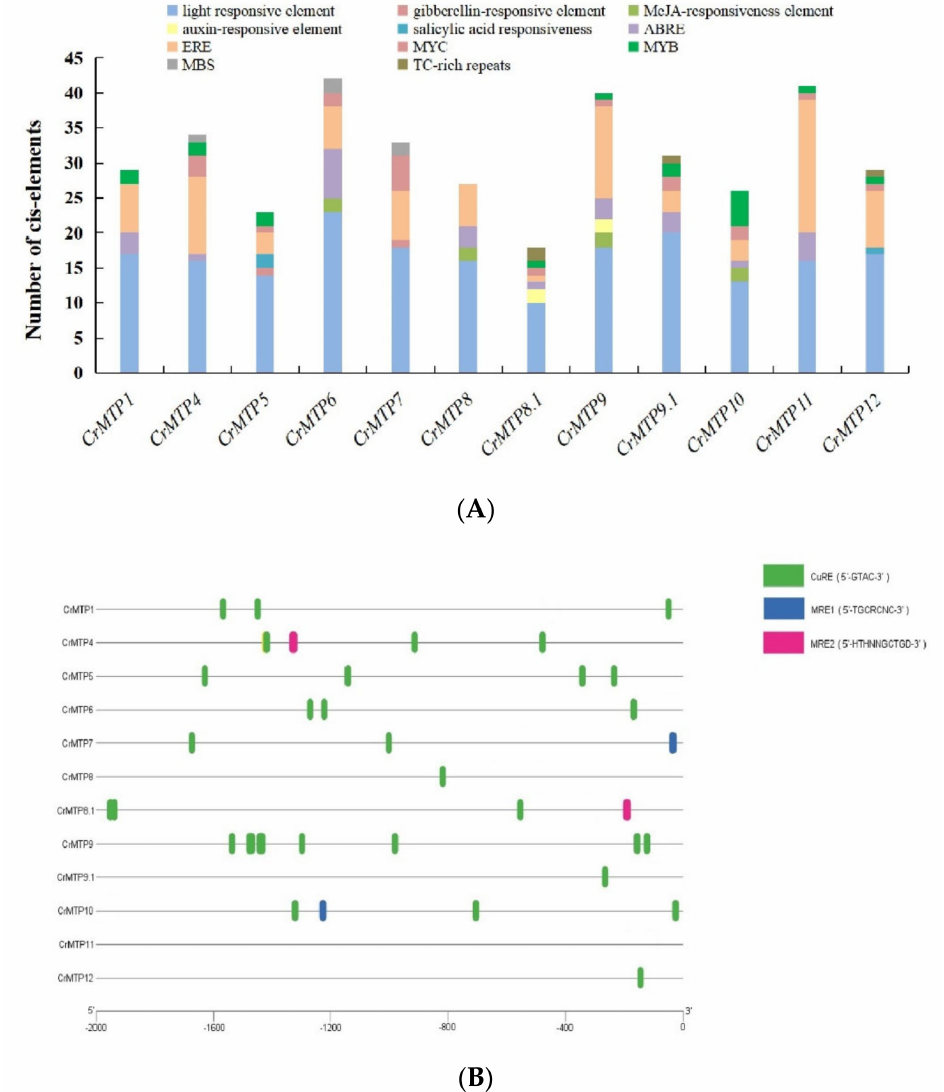
Figure 6. Predicted cis -acting elements in CrMTP promoter regions of C. rosea . The 2000 bp sequence upstream of 12 CrMTP genes’ coding region was analyzed by PlantCARE and manually searched with MRE1, MRE2, and CuRE: ( A ) different cis -acting elements were identified and plotted against a bar diagram. The abundance of different regulatory elements on each of the promoters is shown in different colors; ( B ) the location of metal stress responding cis -acting elements (MRE1, MRE2, and CuRE) in 12 CrMTP promoter